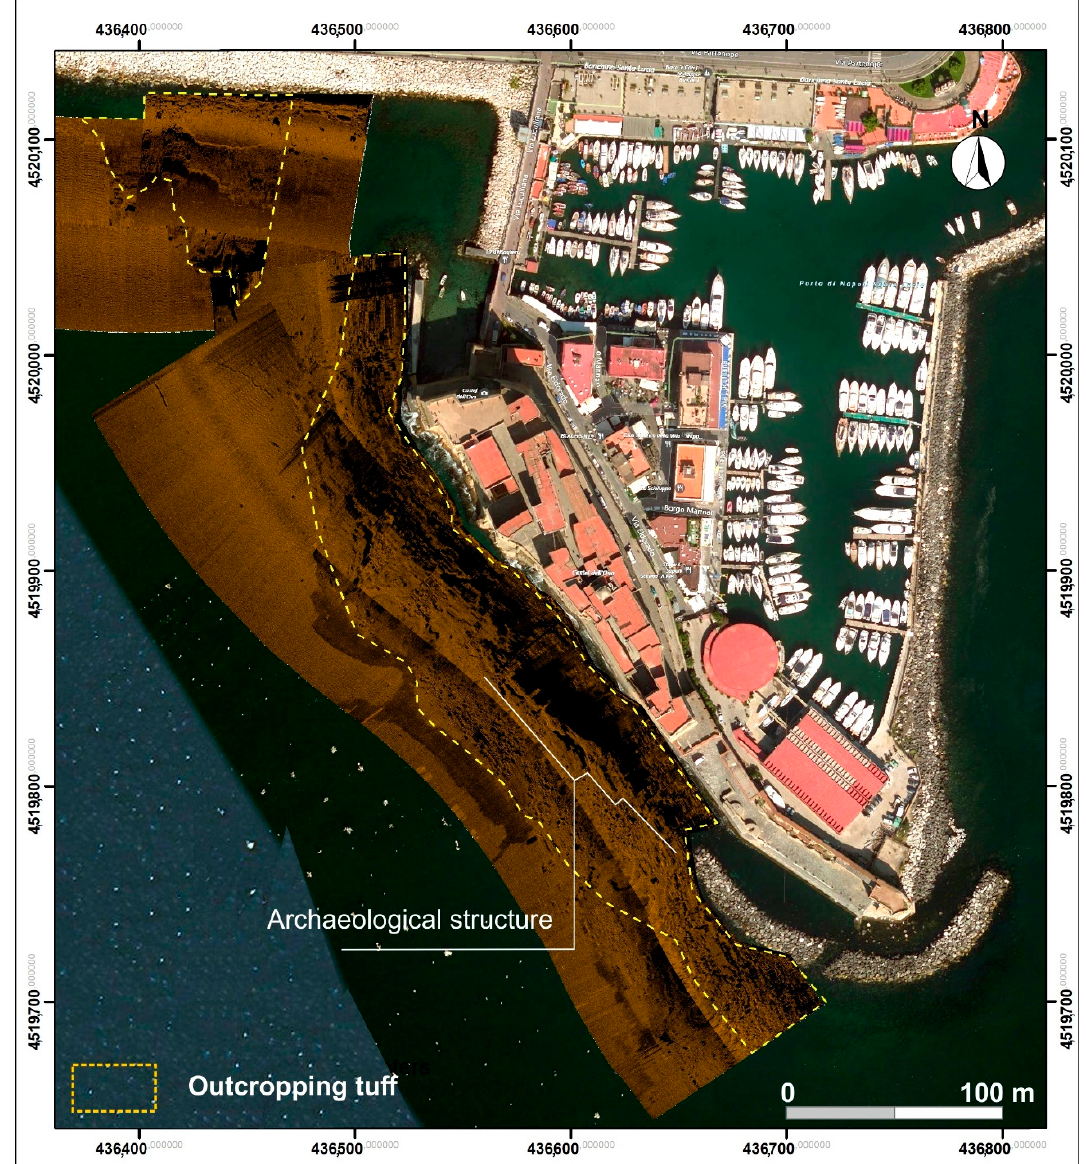
Figure 8. Map of the SSS mosaic with geological interpretations.